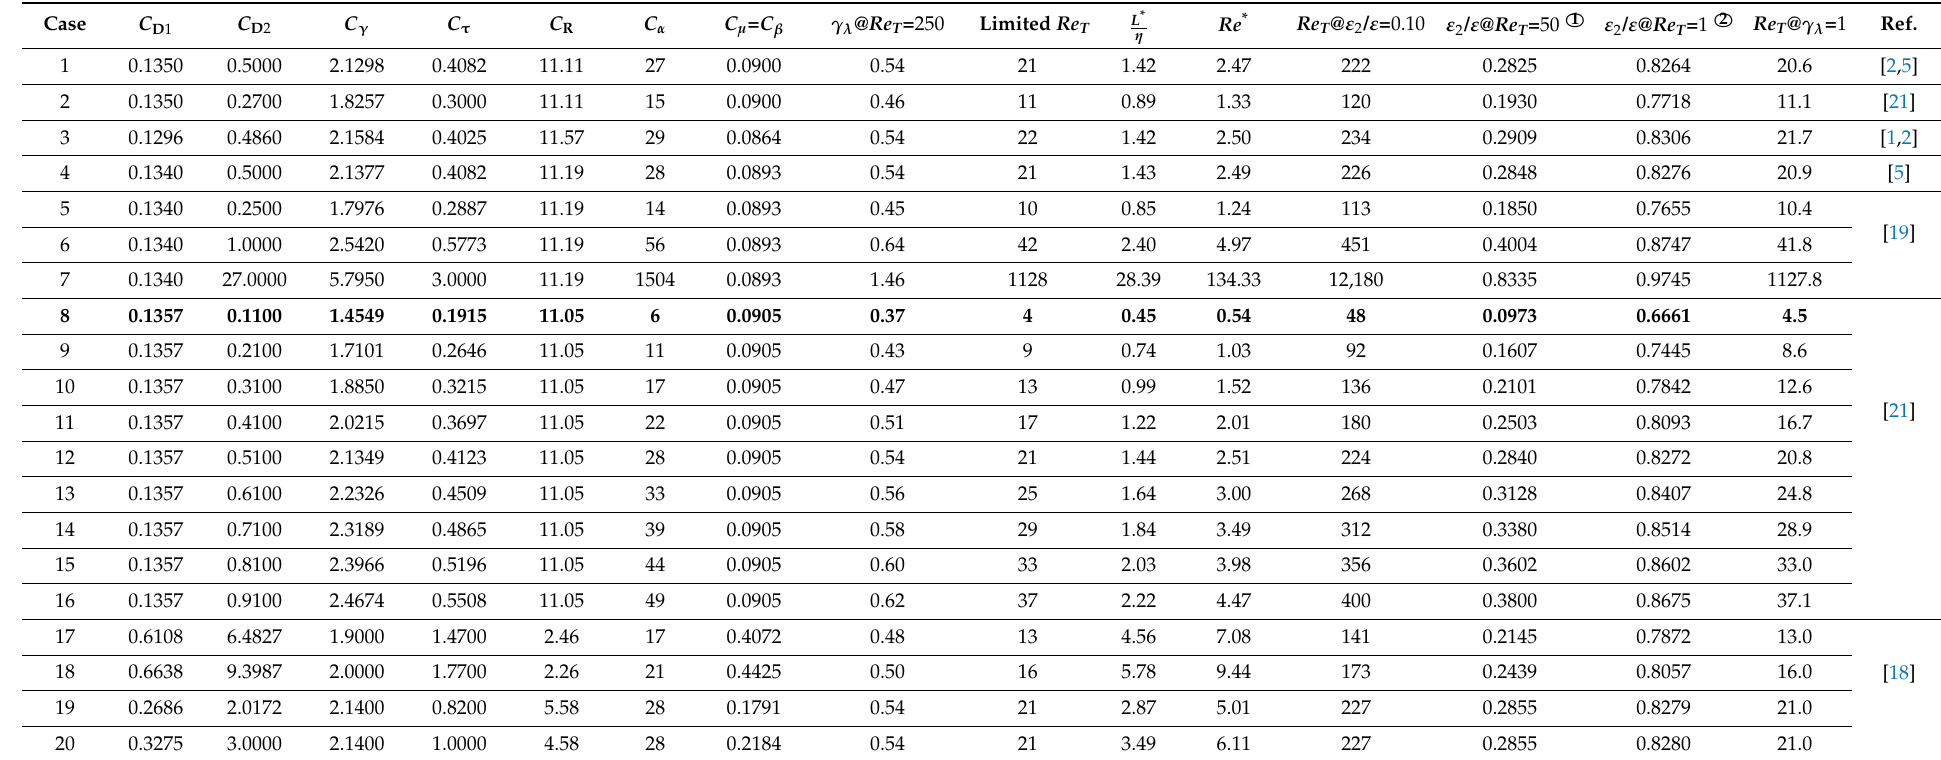
Table 1. Suggested and tried EDC constants and characteristic